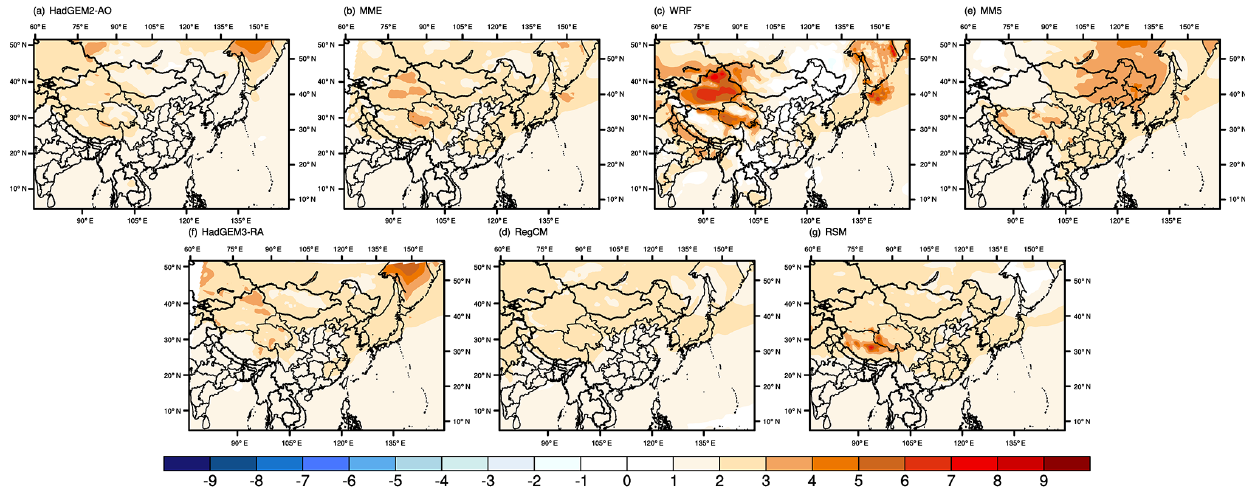
Figure 7. Projected future changes (RCP4.5 − baseline) in surface air temperature by the forcing GCM HadGEM2-AO, the MME, and each of the five RCMs.